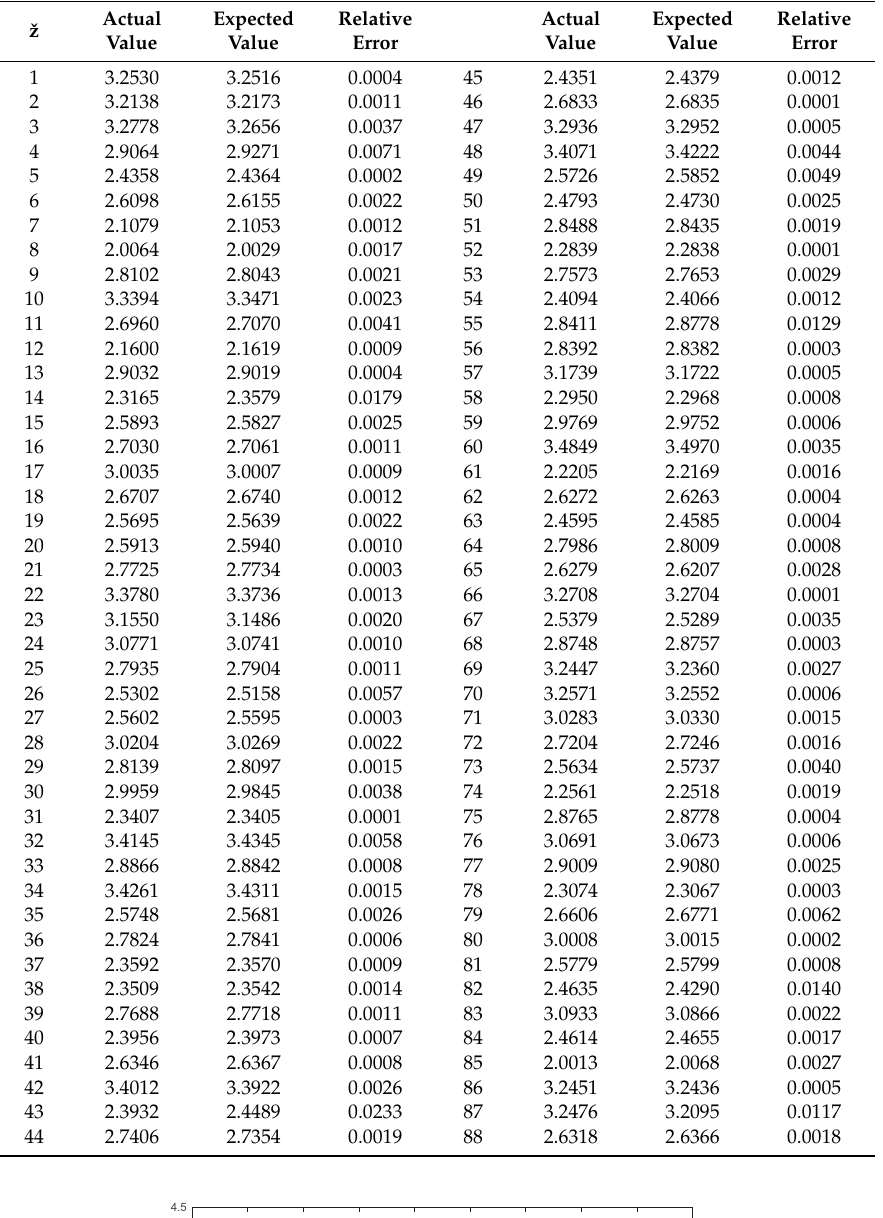
Table A3. Network output results of Hugong community.